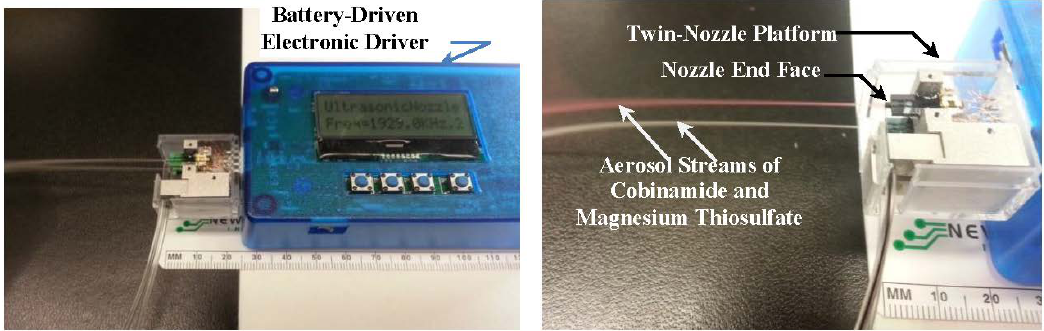
Figure 12. Battery-run pocket-size ultrasonic twin-nozzle nebulizer and twin-nozzle Figure 12